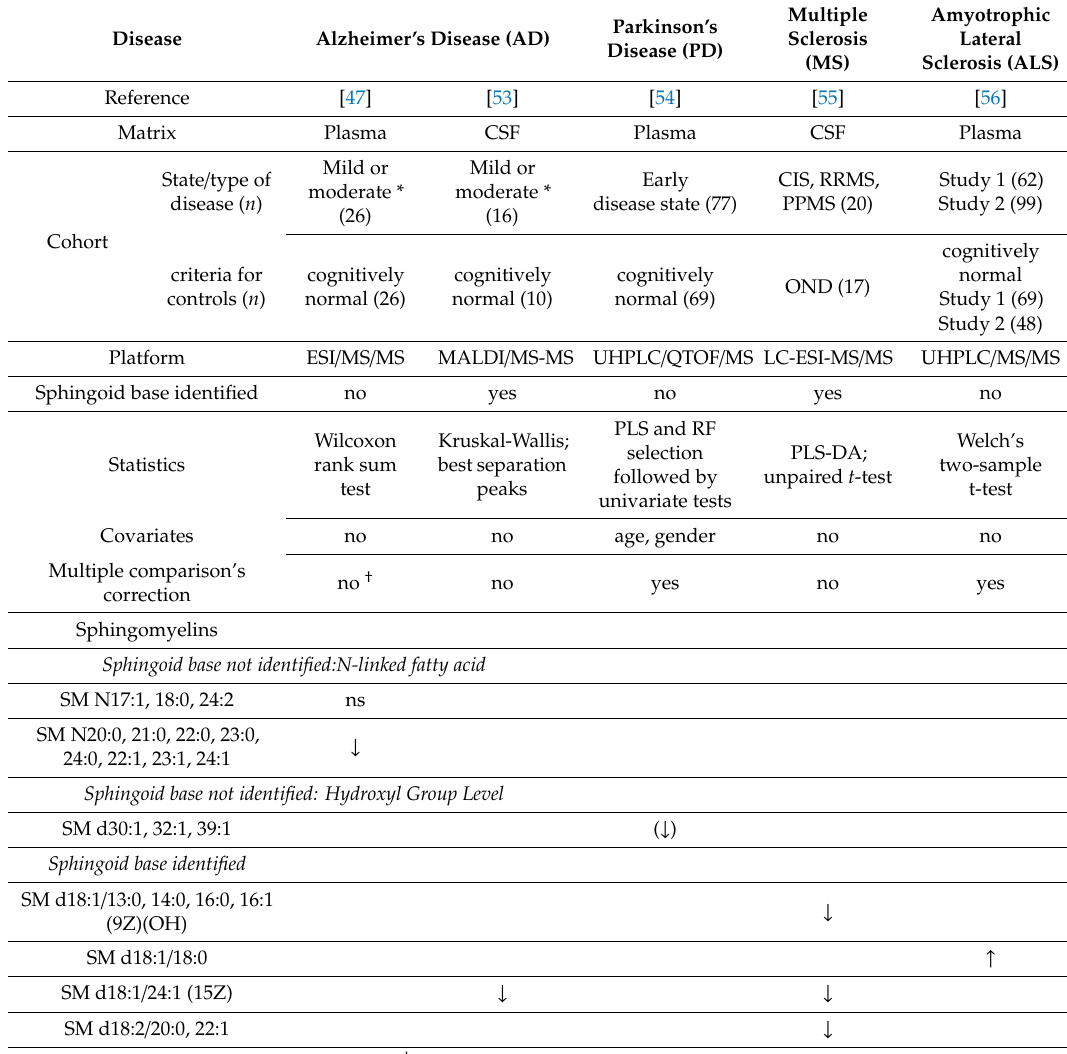
Table 3. Comparison of case-control lipidomic studies reporting alteration of sphingomyelin (SM) species in neurodegenerative diseases. Disease Alzheimer’s Disease (AD)